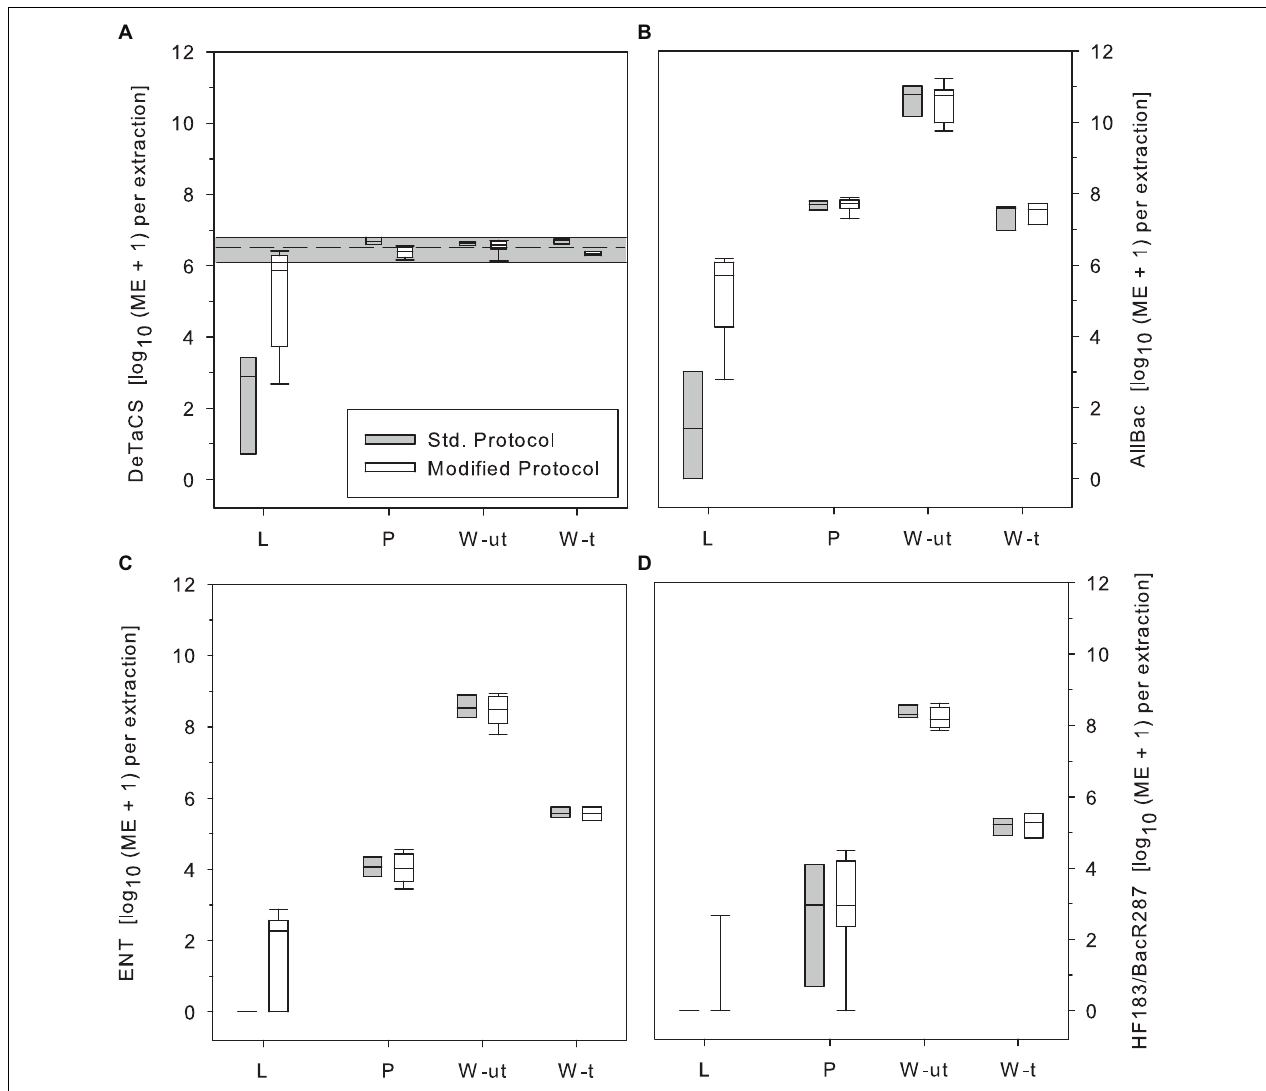
FIGURE 5 | Impact of the applied DNA extraction protocol (standard extraction protocol, gray; addition of salmon sperm DNA, white) on the retrieval of the sample process control (DeTaCS) (A) , the AllBac marker concentration (B) , the qPCR-based ENT marker (C) , and the human-asscoiated MST marker HF183/BacR287 results (D) . Std. Protocol, standard DNA extraction protocol; Modified Protocol, Supplementation of the reaction mixture with salmon sperm DNA during DNA extraction; L, Lake Neusiedl; P, stabilization pond; W-ut, untreated wastewater; W-t, treated wastewater. Boxes, 25th and 75th percentile; lines within the boxes, median; whiskers, 10th and 90th percentile, respectively. n =